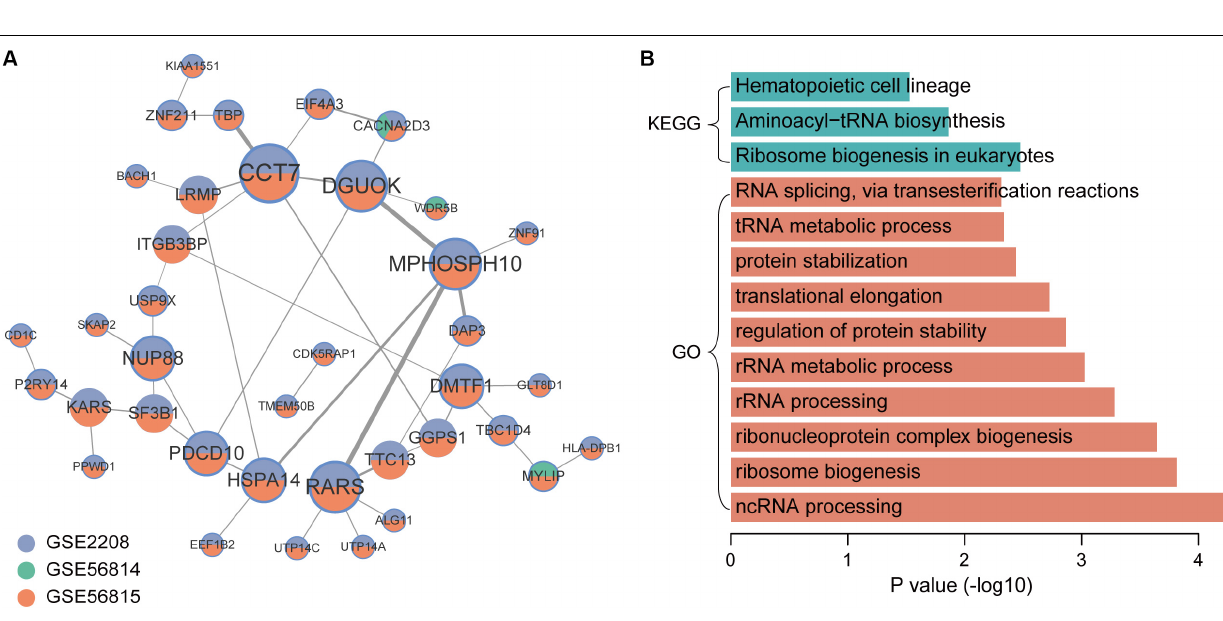
FIGURE 4 | Co-expression network and function enrichment analysis of genes that are consistently expressed in low BMD samples. (A) The gene co-expression network. Node size represents how many other genes interact with it. Node color indicates in which datasets it is up-regulated in low BMD samples. The darker the edge color, the greater the correlation coefficient. (B) GO and KEGG results of genes in